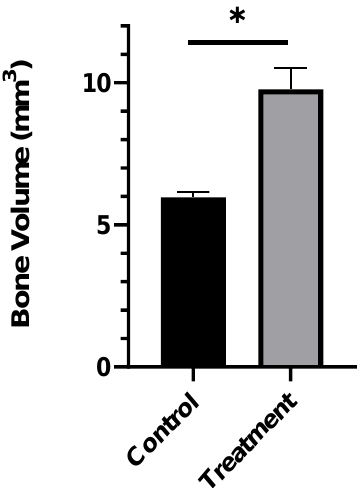
Figure 7. The bone volume in the treatment group (calculated from the µ-CT image) was significantly higher compared to the control group ( n = 3). * p < 0.001.